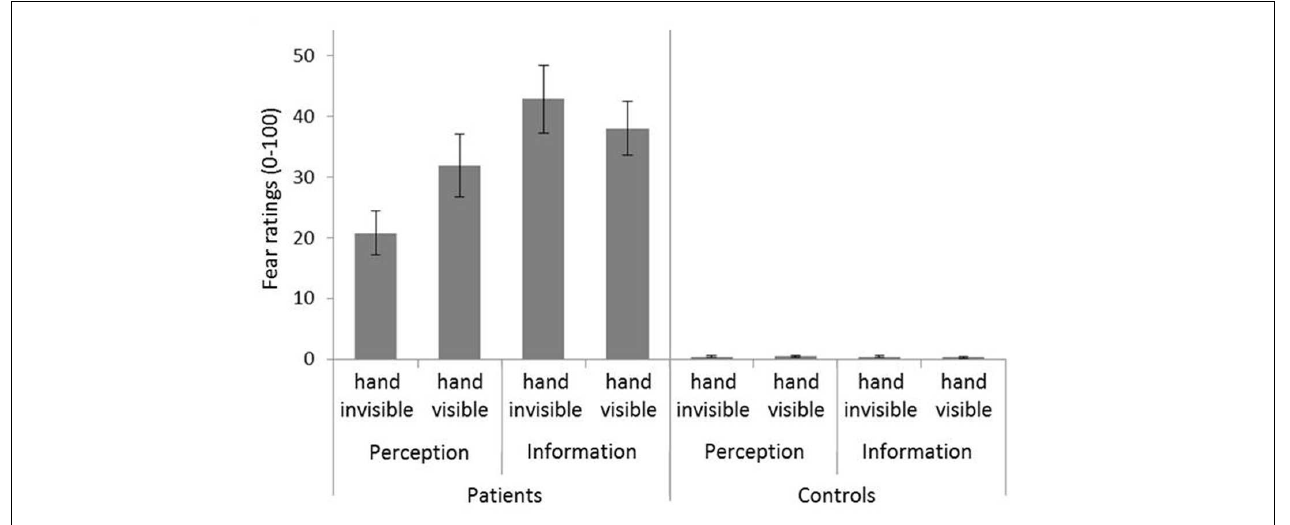
FIGURE 2 | Fear ratings. Mean of all trials is shown. Error bars represent standard errors of the mean.